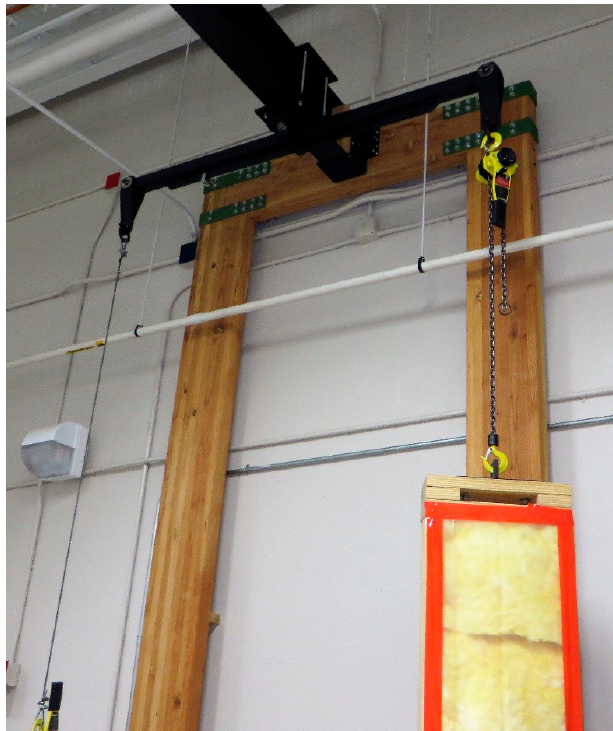
Figure 3. Photograph of balance arm with wall assembly.